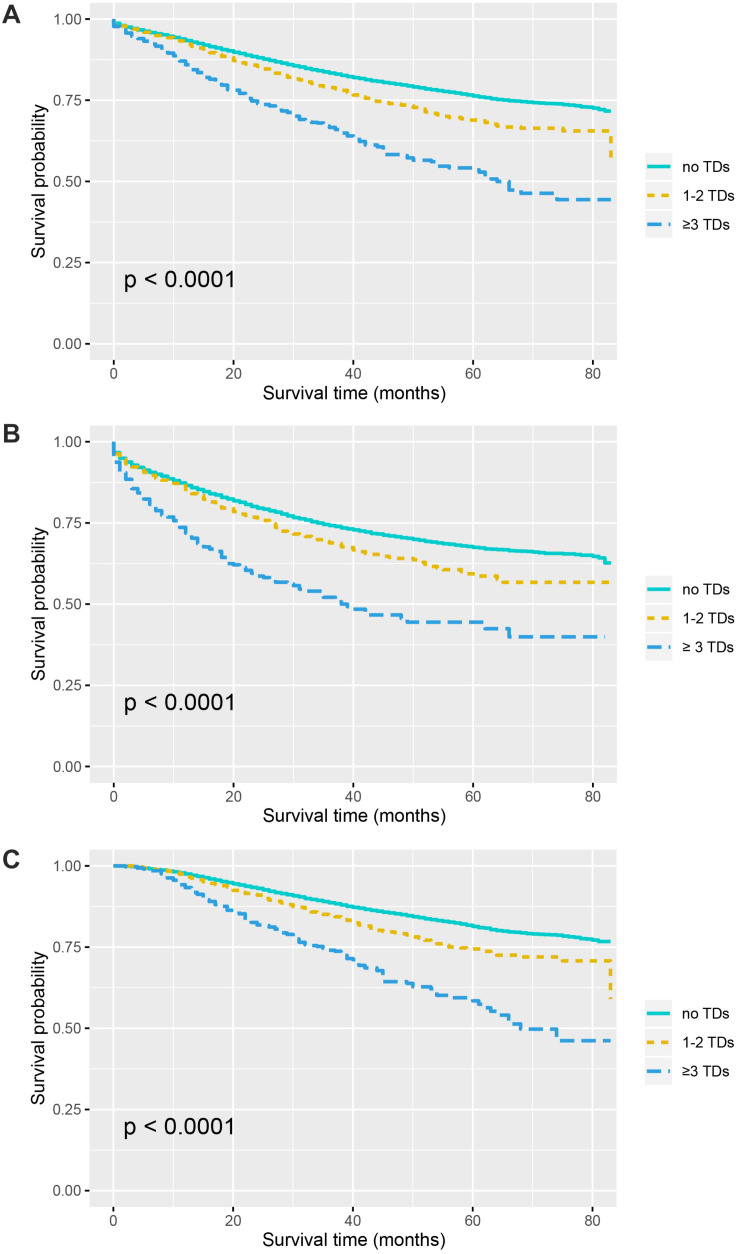
Survival curves for patients stratified by the number of TDs in panel (A) all the patients. (B) Patients without chemotherapy. (C) Patients treated with chemotherapy.